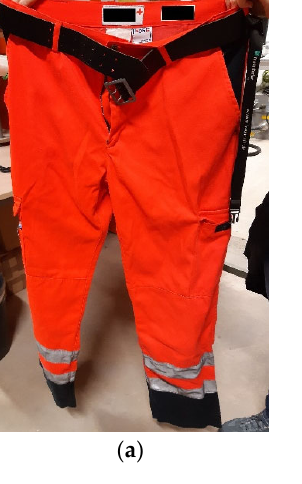
Figure 1. Photos of the investigated workwear. ( a ) Paramedical trousers; ( b ) paramedical jacket; ( c ) civil protection trousers.